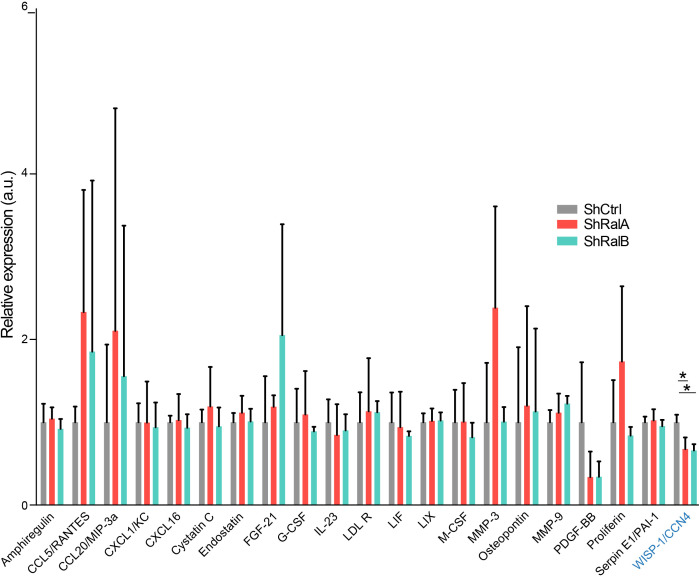
Soluble secretome of 4T1 shControl cells compared to 4T1 shRalA or 4T1 shRalB cells (three independent experiments; One-Way Anova permutation test followed with pairwise permutation test with fdr correction).